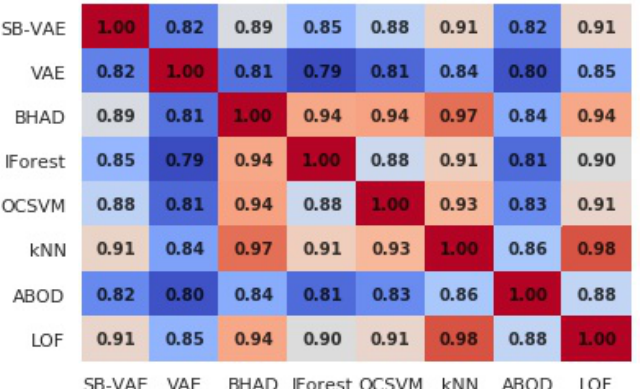
Figure 4. Spearman’s ρ of score